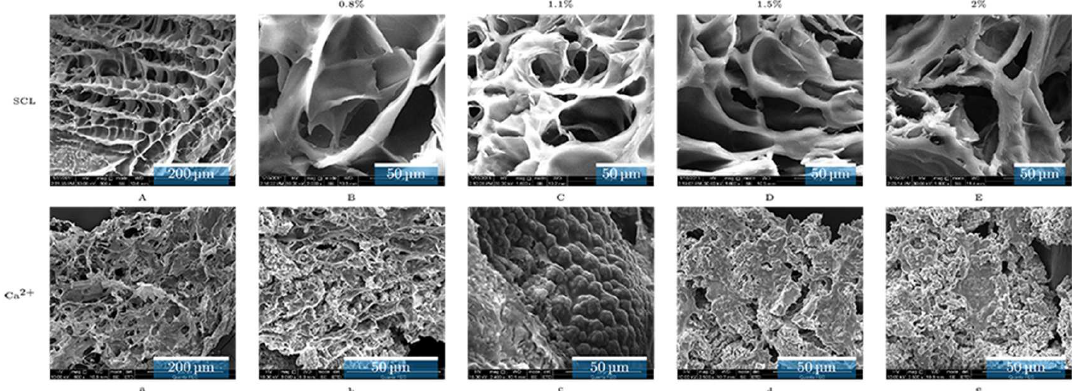
Figure 1. SEM images illustrating the morphology of SCL and Ca 2+ hydrogels: Without cells ( A for SCL hydrogel and a for Ca 2+ hydrogels) and with cells ( B – E for SCL hydrogel and b – e for Ca 2+ hydrogels, both with varying concentrations of 0.8%, 1.1%, 1.5%, and 2%, respectively).